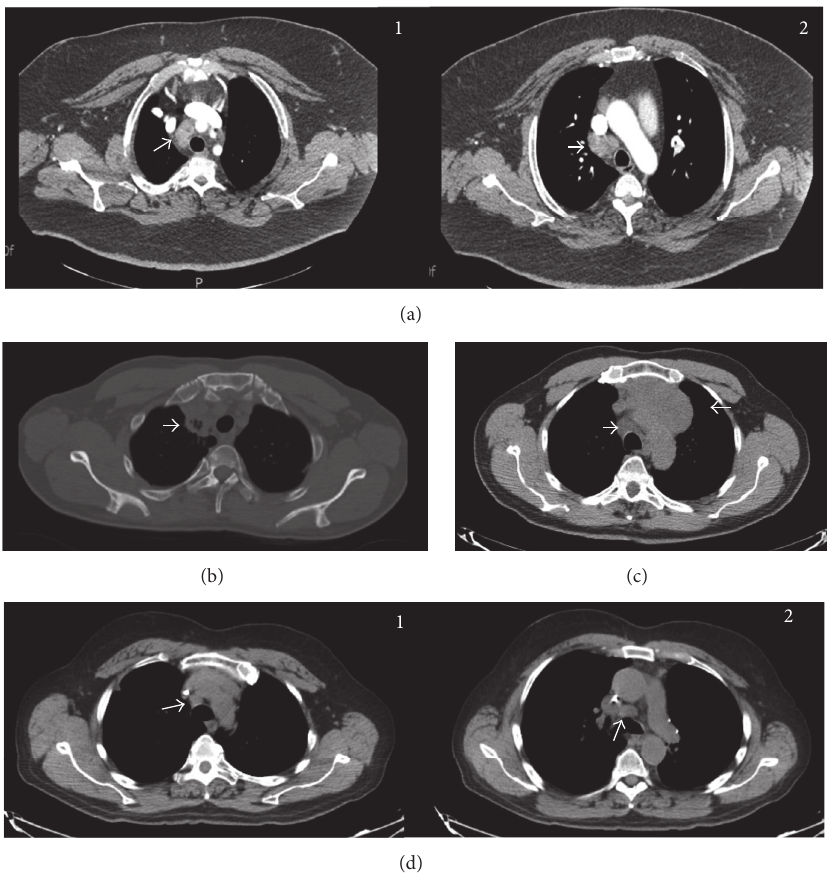
Figure4:Computedtomographychestscanoflesionscompromisingstation2R.(a)Rightparatrachealadenopathyextendingfromstation2R white arrow (Panel 1) to the level of 4R white arrow (Panel 2). (b) Right paratracheal/parenchymal mass (white arrow) compromising vascular structures. (c) Anterior mediastinal mass with pathologic 4R adenopathy (white arrows). Mass extends to the level of 2R. (d) Adenopathy station 2R (Panel 1) and 4R (white arrows) (Panel 2).